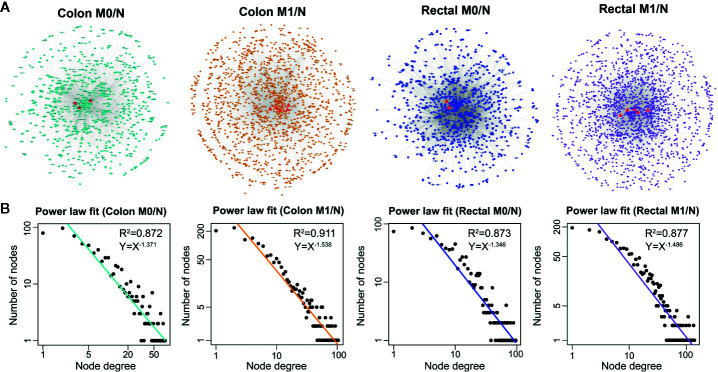
The global view (A) and node degree distribution (B) of the four context-specific LceNETs. The identified lncRNA biomarkers were highlighted by red triangle. M0 represents patients without distant metastasis; M1 represents patients with distant metastasis; N represents paracancerous normal tissue.